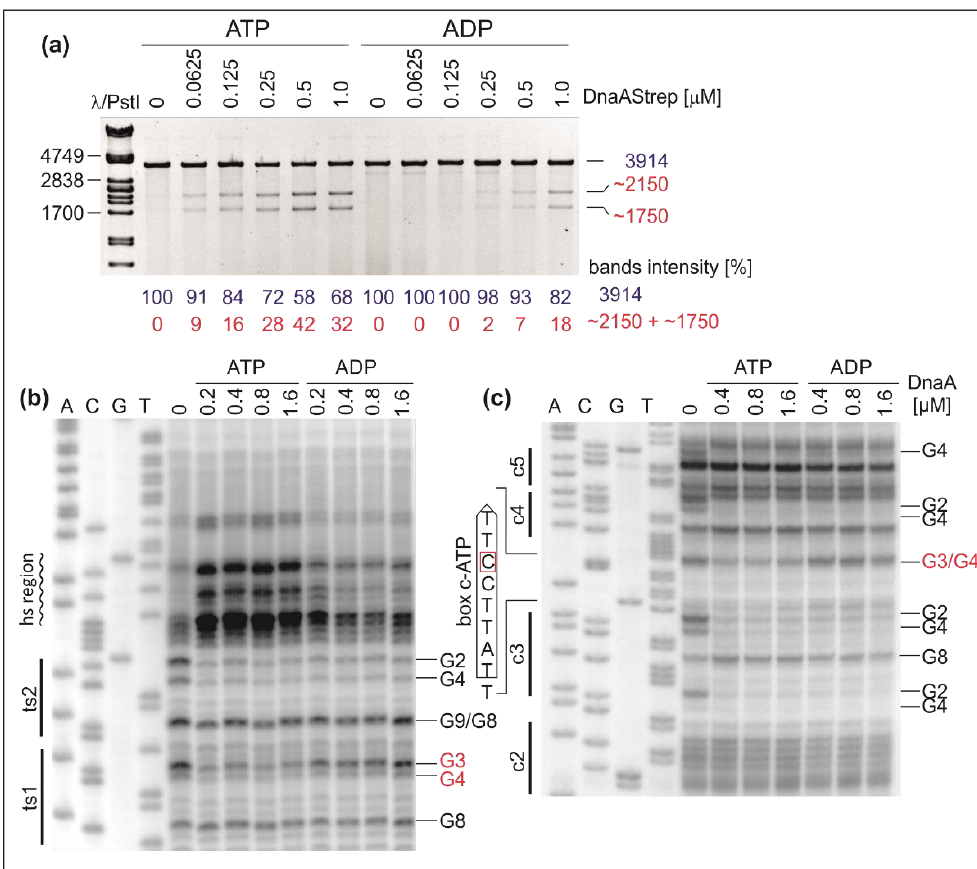
Figure 6. P1 nuclease analysis of DUE unwinding in the presence of ATP/ADP and identification of ATP-dependent DnaA boxes in H. pylori oriC . After incubation with the indicated amounts of DnaA and ATP or ADP, the poriWT plasmid was either treated with P1 nuclease, BglII digested, and resolved by agarose gel electrophoresis ( a ) or modified with DMS and used as a template in PE reactions containing 32 P-labeled primers E1 ( b ) and E2 ( c ). The protected guanine residues (G) are to the right of the gels. Except for the newly identified box c-ATP DnaA, for which the DNA sequence is presented, the DnaA boxes are marked by continuous lines.